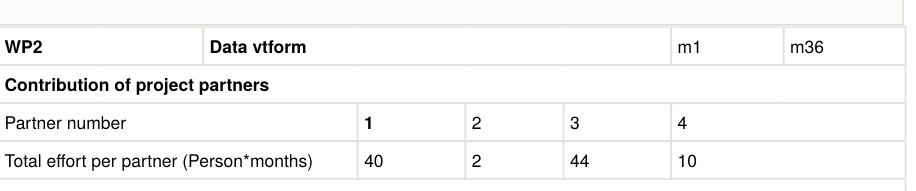
Work Package 2. Data visualisation and collaboration